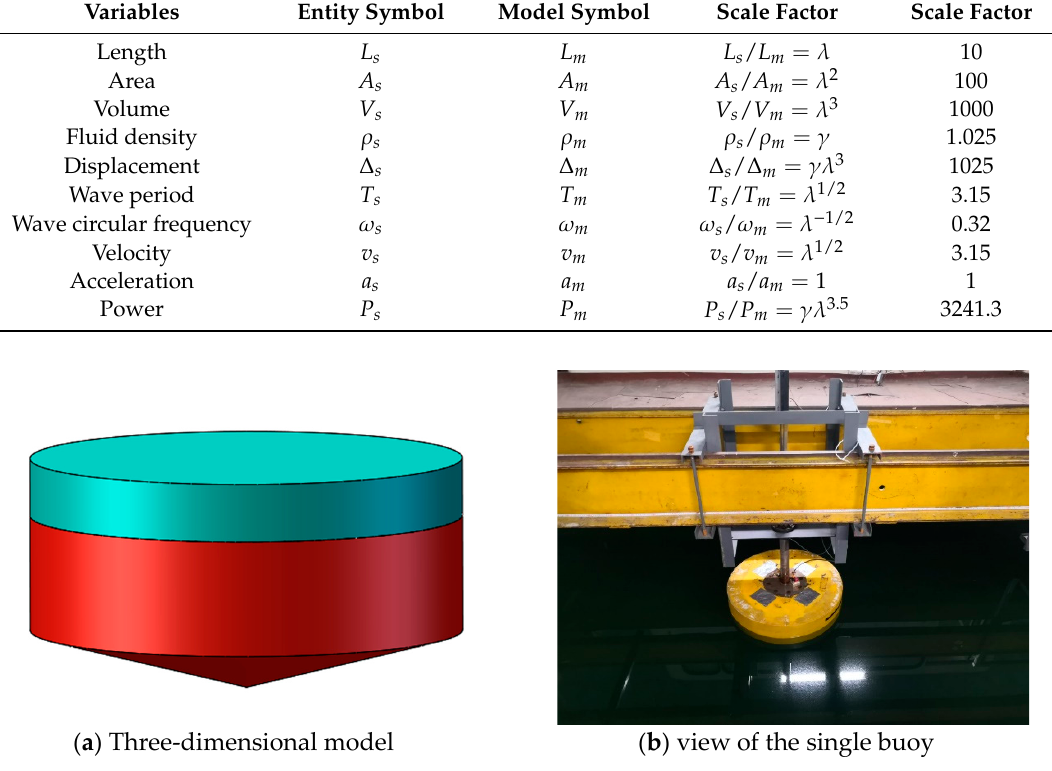
Figure 2. The three-dimensional model and photography of single buoy.